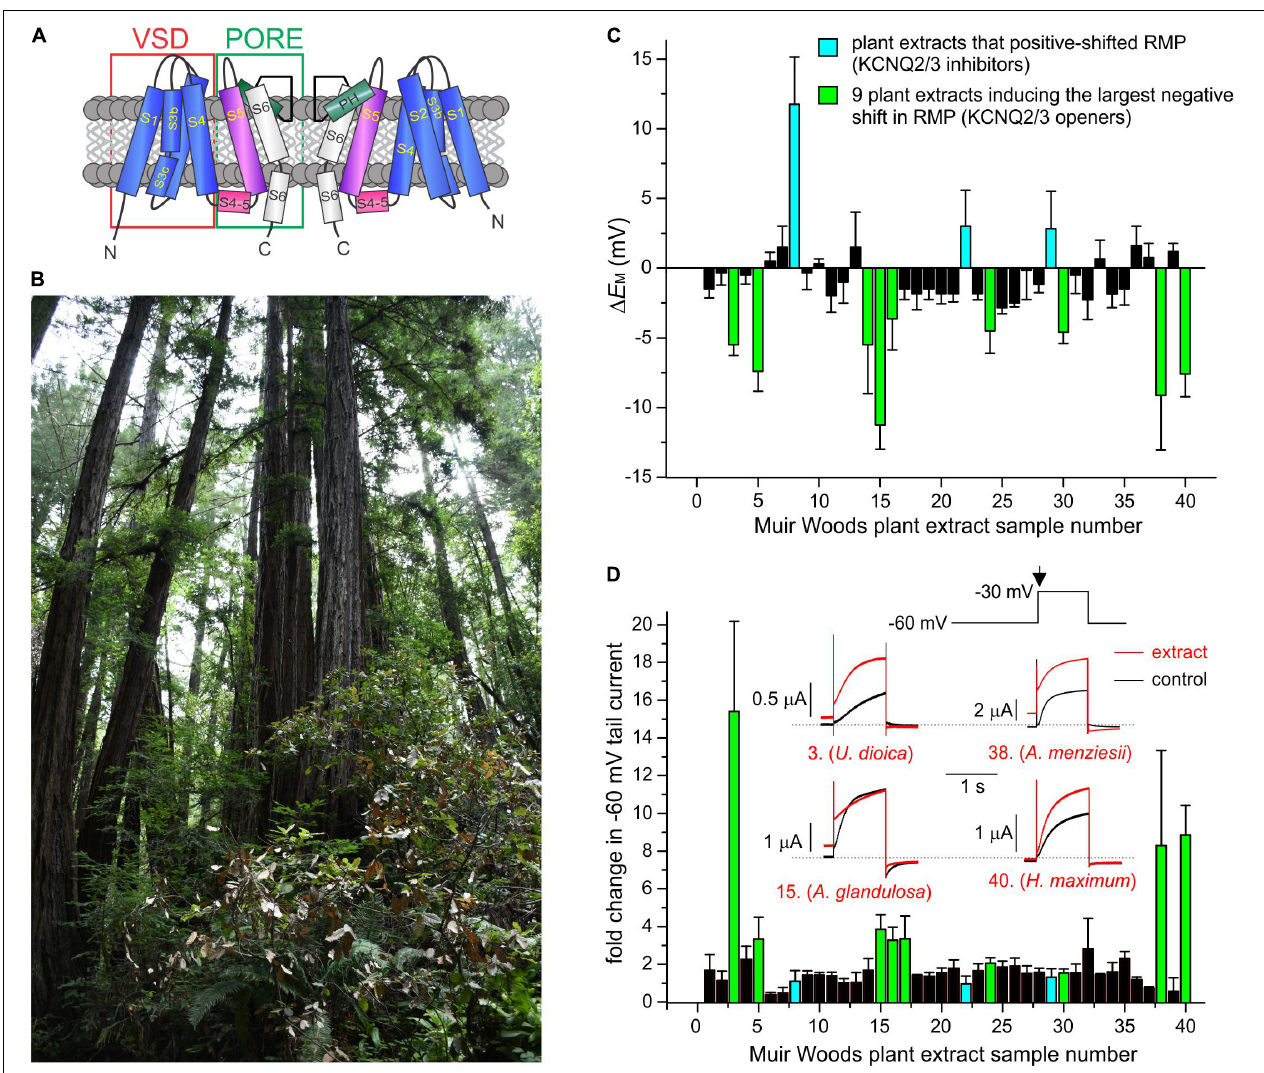
FIGURE 1 | Screening Muir Woods plant extracts for KCNQ2/3 opening activity. All error bars indicate SEM. n = number of oocytes. (A) Topological representation of a Kv channel showing two of the four subunits that comprise a channel. PH, pore helix. VSD, voltage sensing domain. (B) Image of area of Muir Woods from which plants were collected. (C) Screen of 40 Muir Woods plant extracts (1:50 dilution) showing their effects on E M ( (cid:49) E M compared to control) of Xenopus oocytes expressing human KCNQ2/3; n = 3–11 per extract. (D) Screen of 40 Muir Woods plant extracts (1:50 dilution) showing their effects on Xenopus oocytes-expressed KCNQ2/3 current at –60 mV (fold-change compared to control) n = 3–8 per extract. Columns colored according to key in panel (C) . Inset: exemplar KCNQ2/3 tail current traces in bath solution (black) or with each of four of the KCNQ2/3-activating plants extracts in the screen (red), using the voltage protocol shown upper right. Arrow: time point on voltage protocol at which tail currents are measured. Dashed line here and throughout indicates zero current level.